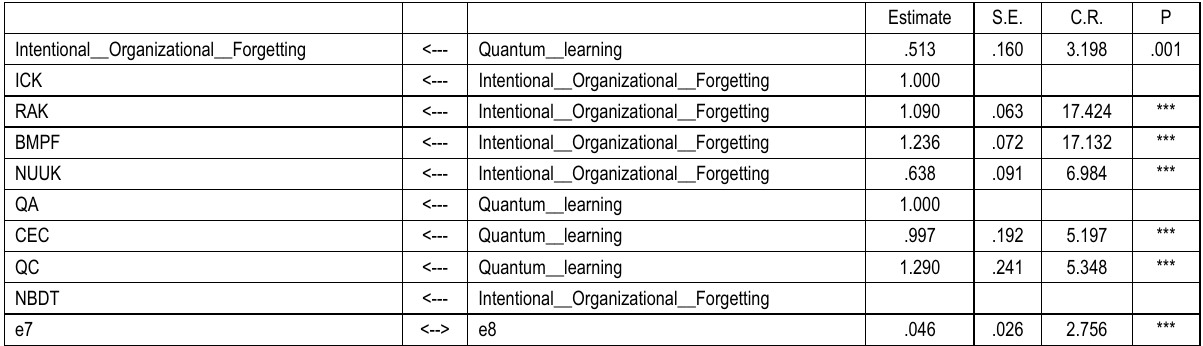
Table 4 lists the results as with significance of the path coefficients of the modified model. Table 4. Significance of path coefficients